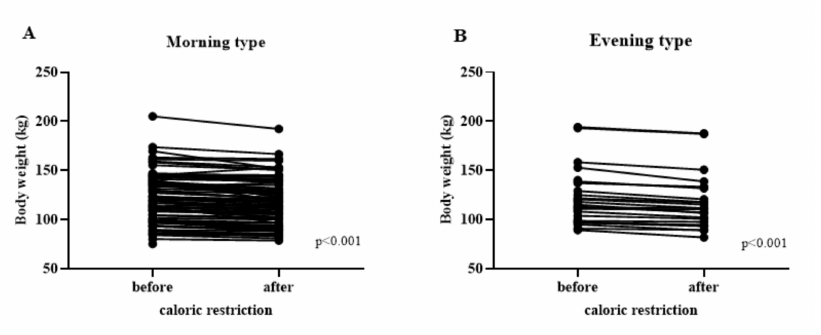
Figure 2. Body weight before and after caloric restriction. Wilcoxon signed-rank test. Individual datapoints linked by a line for: ( A )—morning chronotype ( n = 98), ( B )—evening chronotype ( n =